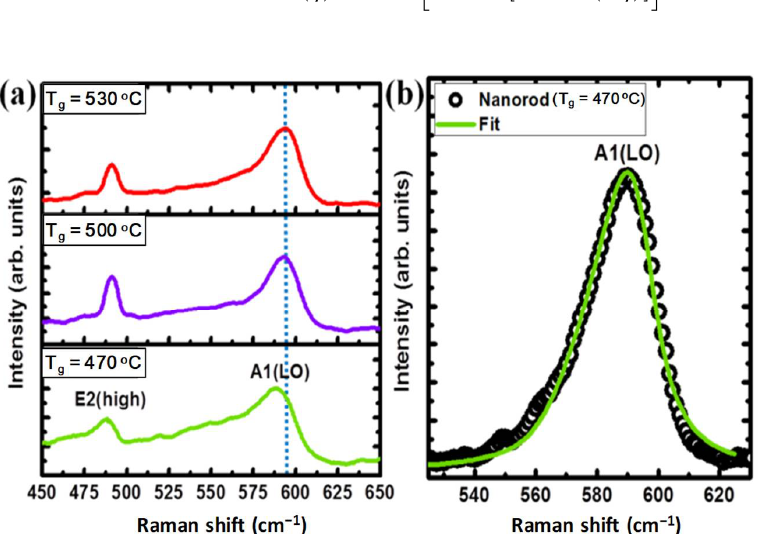
Figure 6. ( a ) Raman spectra with E 2 (high) and A 1 (LO) phonon modes. ( b ) The A 1 (LO) phonon of nanorods with fitting curve by spatial correlation model.